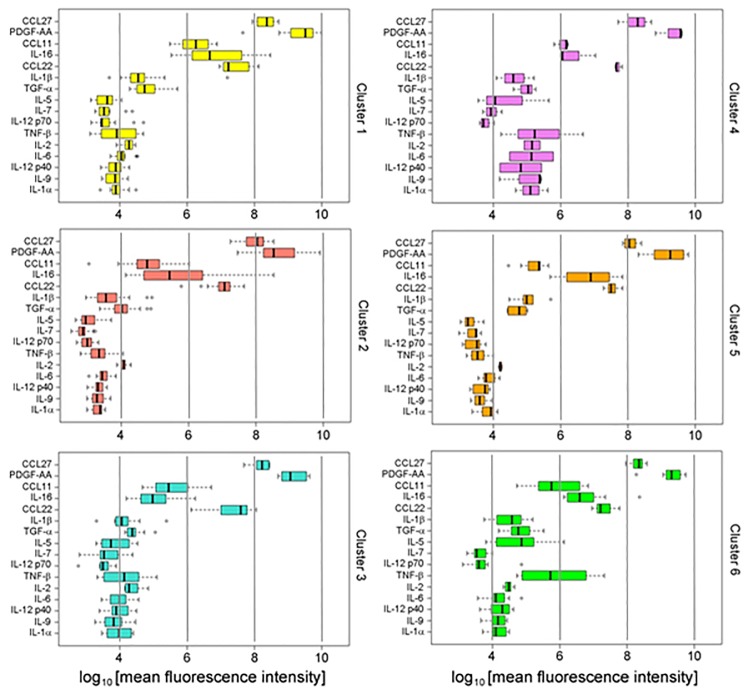
Six-cluster signature in BWHS subjects taking metformin or NSAIDs.Patterns of sixteen cytokines by signatures assigned with the multi-label classification algorithm. The algorithm used the profiles of cytokines discovered in the original BWHS set of sixty two subjects to infer the most likely signature of fifty eight other subjects, who had been excluded from the first analysis because they were taking medications. The six signatures are very similar to those calculated for Fig 2 subjects, who were not taking medications. Only the distribution of CCL22 in Cluster 3 differed significantly (P-value = 0.003) from the distribution of CCL22 in patients assigned to the same Cluster 3 in the discovery set (Fig 2). For all other signatures, the difference in distributions of individual cytokines by cluster was tested using t-test and no other comparison reached statistical significance after Bonferroni correction for multiple testing (P < 0.003).